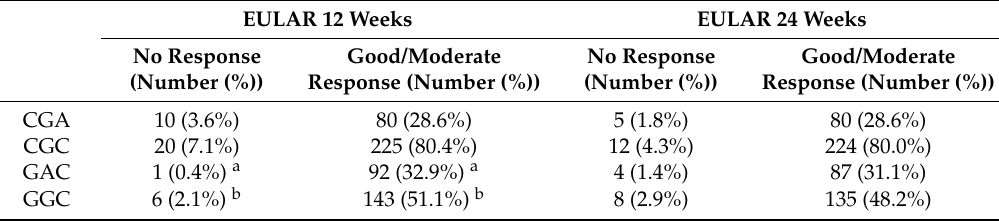
Table 5. Relationships of the NKG2D haplotypes with EULAR responses at 12th and 24th week of anti-TNF therapy EULAR 12 Weeks EULAR 24 Weeks No Response (Number (%))